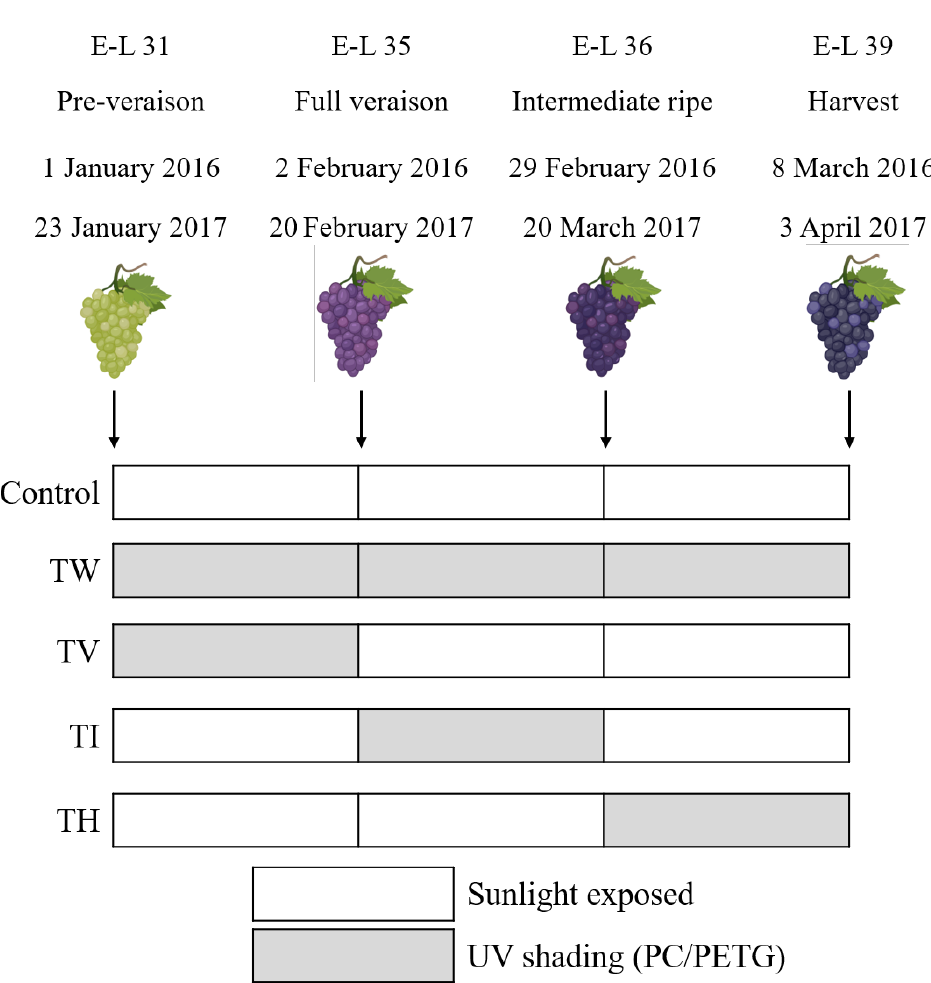
Figure 1. Experimental design for the ultraviolet (UV) attenuation trial at different phenological stages of grapevine development. The treatments were as follows: (i) control: grape bunches were naturally exposed to sunlight; (ii) grape bunches were enclosed by polyethylene terephthalate glycol (PETG) or polycarbonate (PC) film from pre-veraison to harvest (TW PETG/TW PC); (iii) grape bunches were enclosed by PETG or PC from pre-veraison to full veraison (TV PETG/TV PC); (iv) grape bunches were enclosed by PETG or PC from full veraison to intermediate ripe (TI PETG/TI PC); (v) grape bunches were enclosed by PETG or PC from intermediate ripe to harvest period (TH PETG/TH PC).